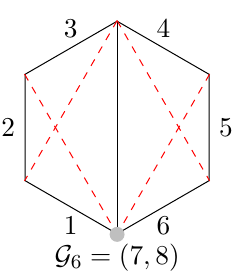
2 ) (1 , 2 , 3 , 6 , 5 , 4 | 1 , 2 , 3 , 4 , 5 , 6 , 7 , 8) . The black diagonal Figure 10. Factorization channels for F tr( φ 8 represent s and their complementary 4 , 5 , 6 , s 4 , 5 , 6 , 7 , s 4 , 5 , 6 , 7 , 8